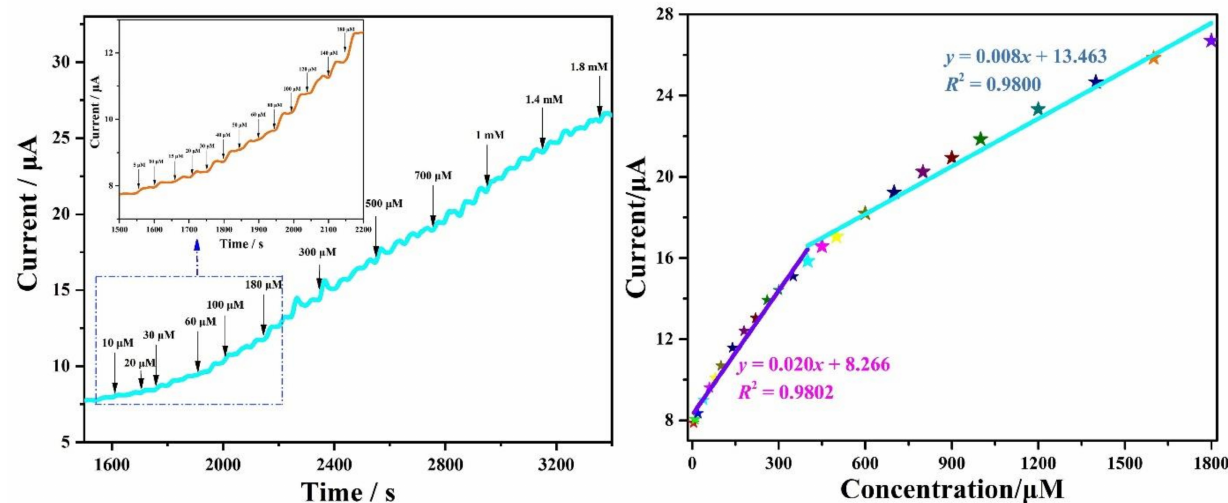
Figure 6. ( a ) The chronoamperometric curve of Cu@Co–MOF/GCE to C Glu ranging from 0.005 to